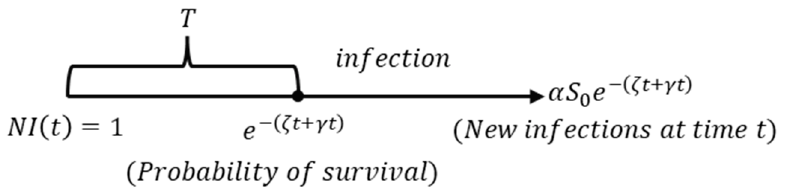
Figure 4. The evolution of infective individuals, where ( S 0 ,0, 0 ) is the disease-free equilibrium in the feasible region Γ .